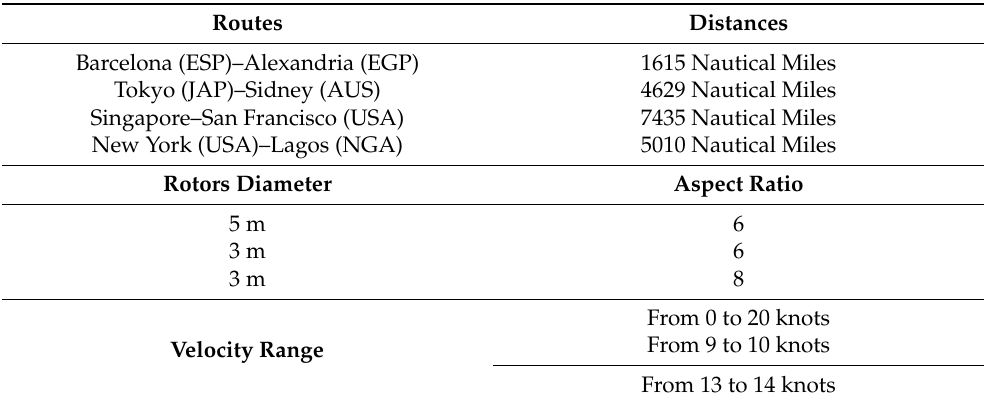
Table 5. Simulations